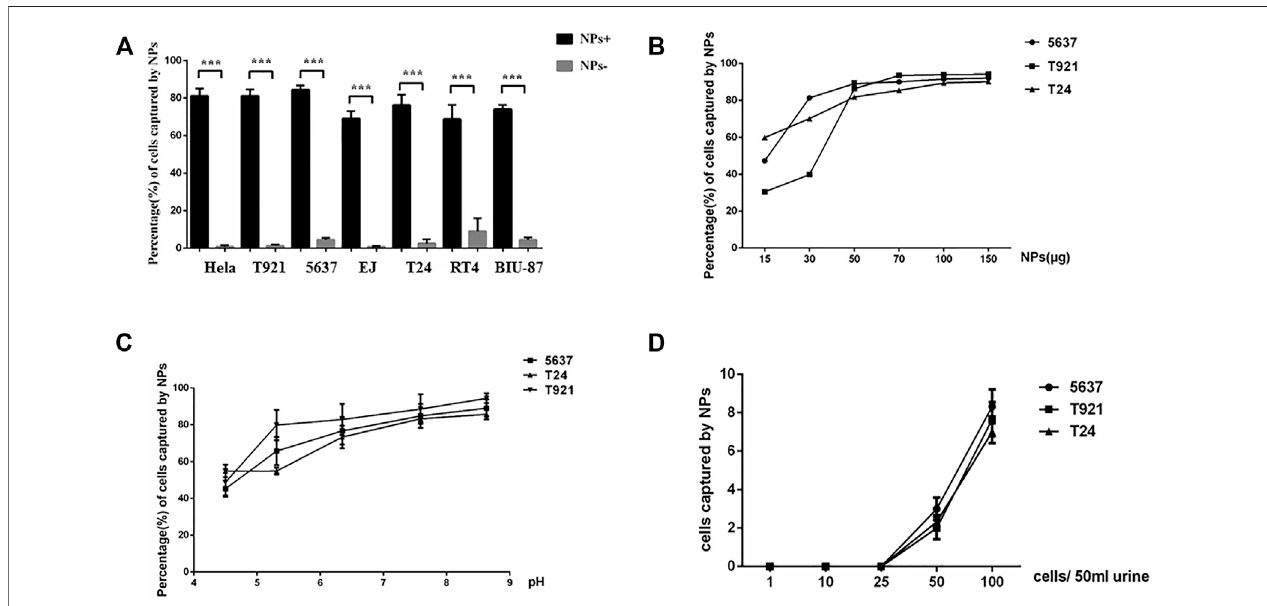
FIGURE 2 | Interaction of the mNPs with bladder tumor cells. (A) Positive mNPs and negative mNPs have completely different patterns of interaction with bladder tumor cells. *** p < .001. (B) The magnetic capture ef fi ciencies of bladder tumor cells by NPs of positive charges are plotted at various mNP concentrations. (C) The magnetic capture ef fi ciencies ofbladder tumor cells bymNPsof positive charges are plotted at various pH value. (D) Positive mNPscan capture cancer cell if more than 50 cells in 50-ml samples were given.